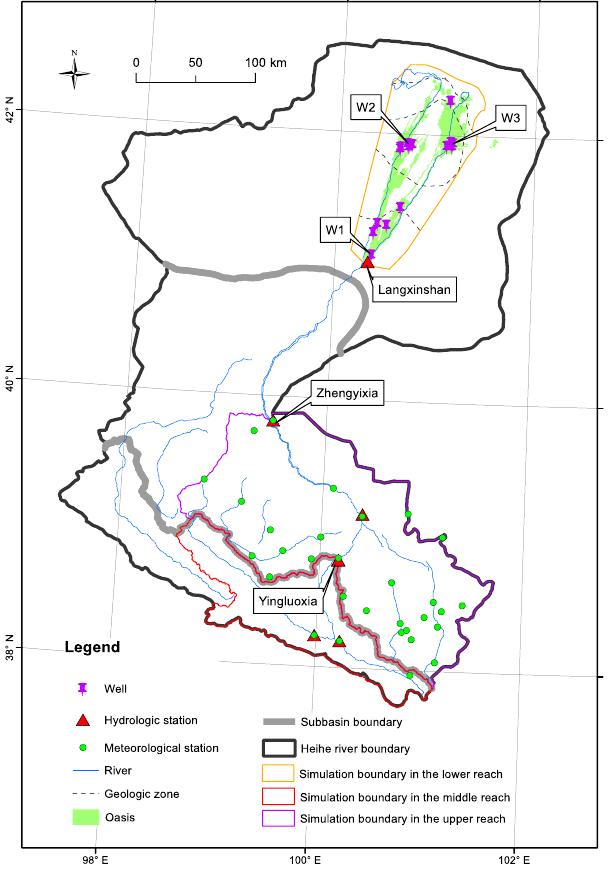
Figure 1. The Contour of Heihe River Basin and the three reaches together with the meteorological stations and hydrological stations.